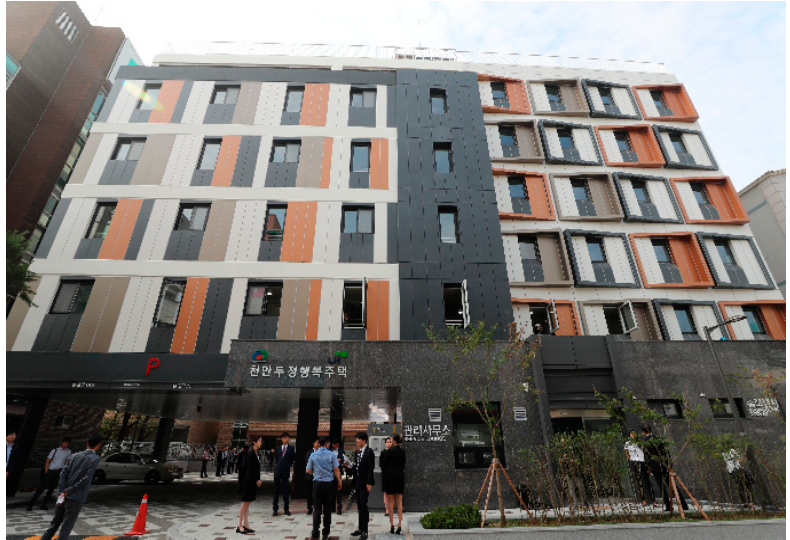
Figure 3. Front view of target building.